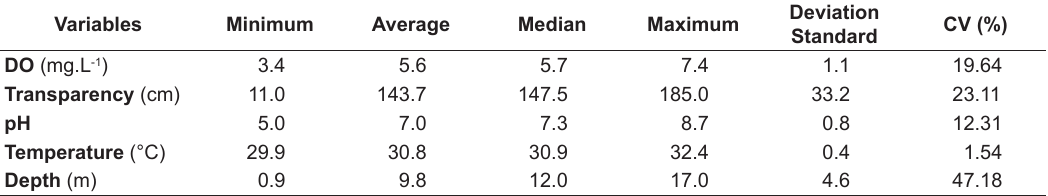
Table 1. Descriptive statistical analysis of the parameters of the limnological Proxies of water samples taken at the Curuá-Una HPP reservoir in November 2016.